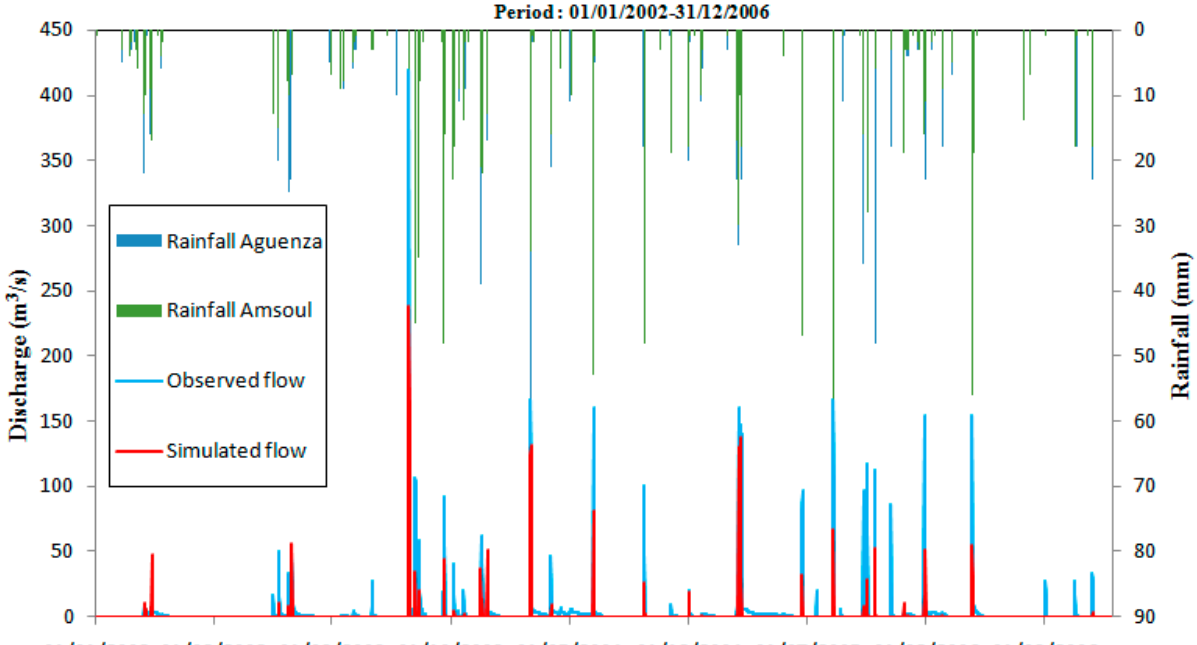
Figure 8. Illustration of the GR4J model output visualization during the period between 2002 and 2006.